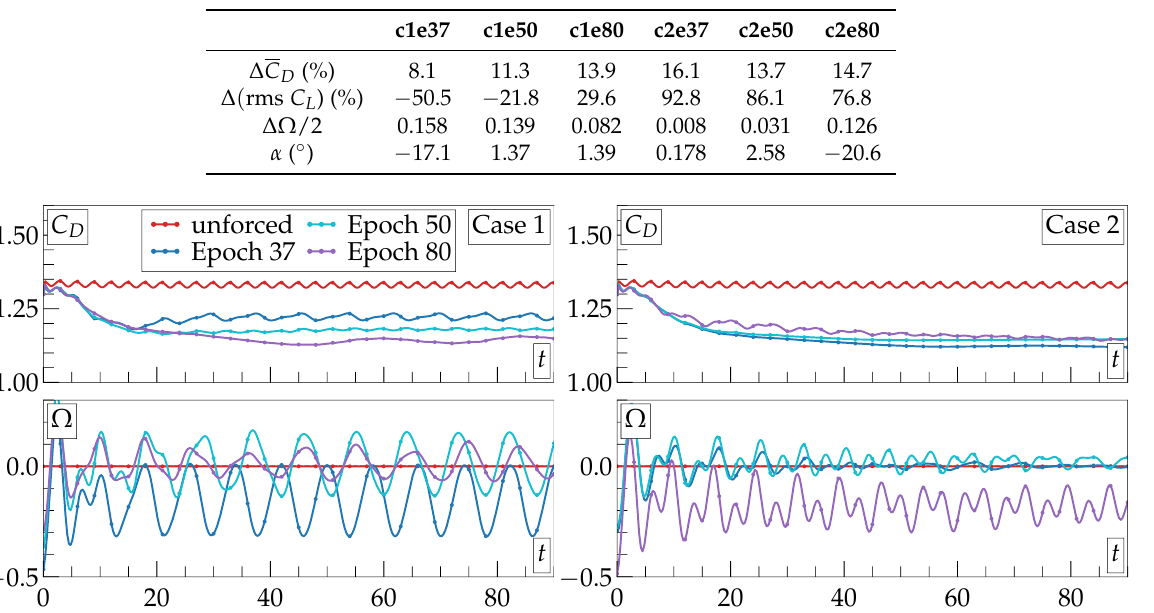
Table 1. Characteristics of several flow regimes corresponding to the number of epoch during the training process, as depicted in Figure 4 by square points.